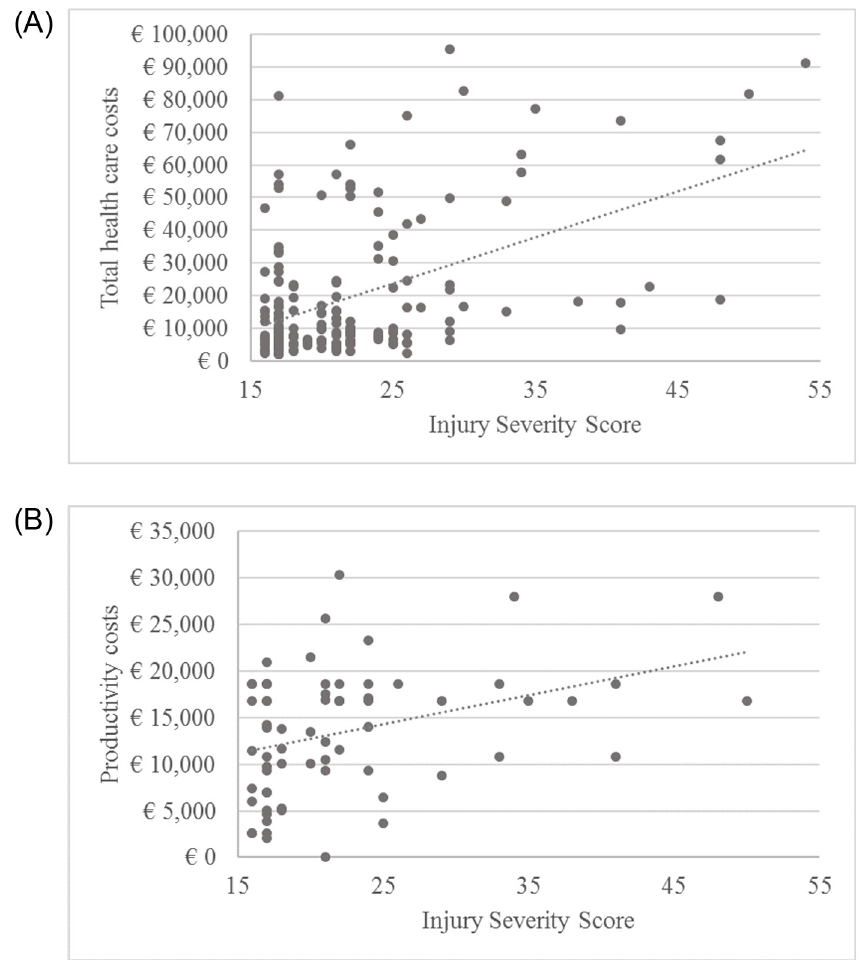
Fig 2. A. Association between injury severity score and total health care costs. B. Association between injury severity score and productivity costs based n = 67 with paid employment and data on productivity loss costs.